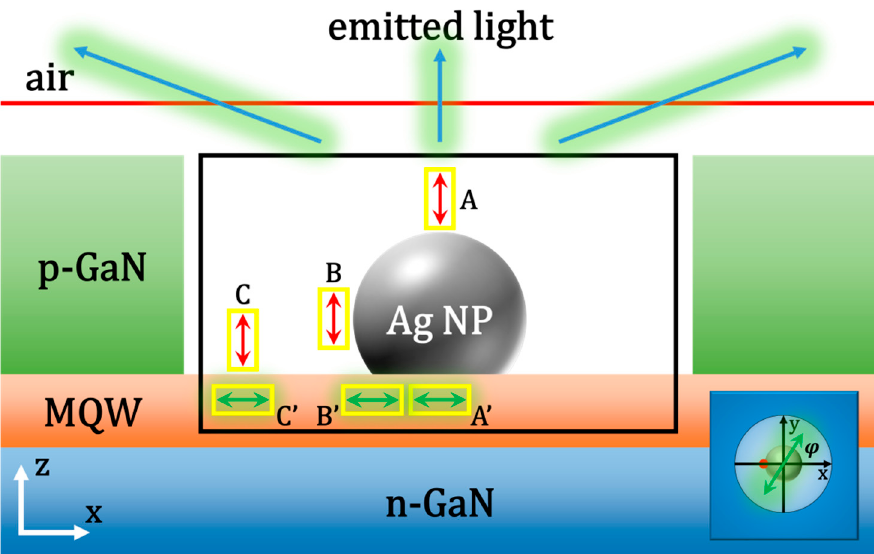
Figure 3. The schematic structure in the three-dimensional (3D) finite difference time domain (FDTD) simulation. The black box monitor is used to collect the scattered power of the whole three-body system. The yellow transmission boxes are used to record the radiated powers of the z-dipole and q-dipole. The red plane monitor is used to record the power emitted from the top surface. The red and green double-headed arrows represent the e-beam and the QW, respectively. The inset shows the polarized angle ( (cid:2030) ) of the q-dipole.